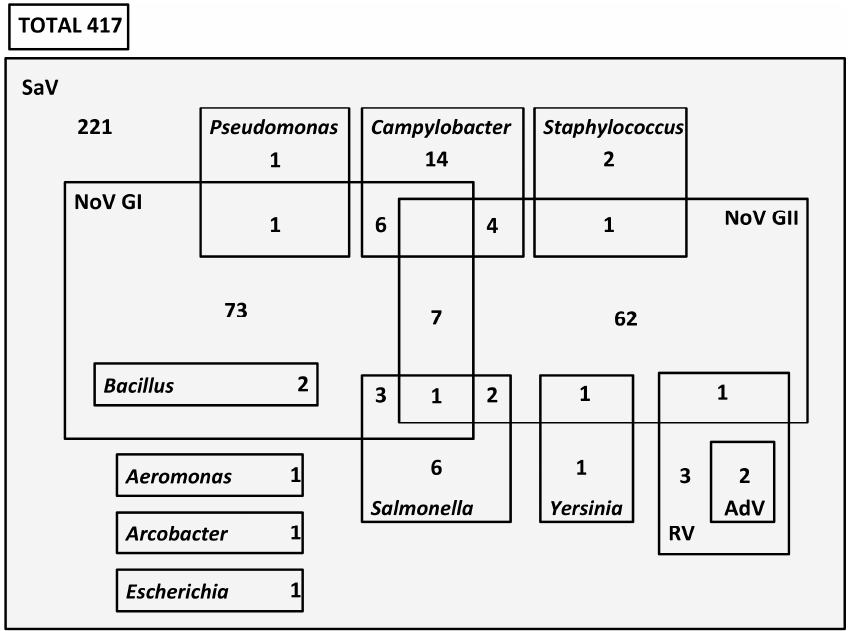
Figure 2. Diagram showing the number of SaV coinfections with other viral and bacteriological agents. Data for other pathogens obtained from a previous study [10].